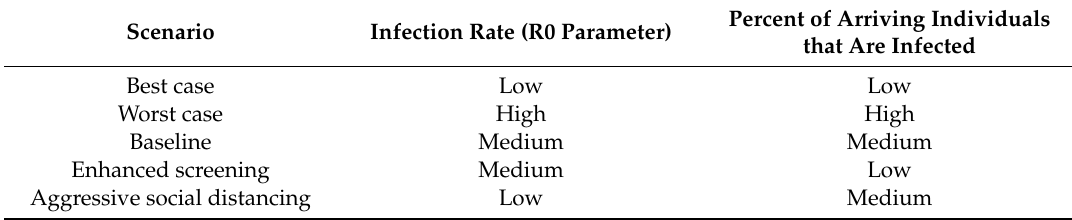
Table 2. Scenarios and corresponding model parameters. The infection rate parameter is drawn from [16]; medium is the baseline observed rate of 2.38, low is half of the baseline (1.34), and high is twice the baseline (5.36). The percentage of individuals arriving at the fire infected is varied from low (0.1%) to medium (1%) to high (5%); see Table